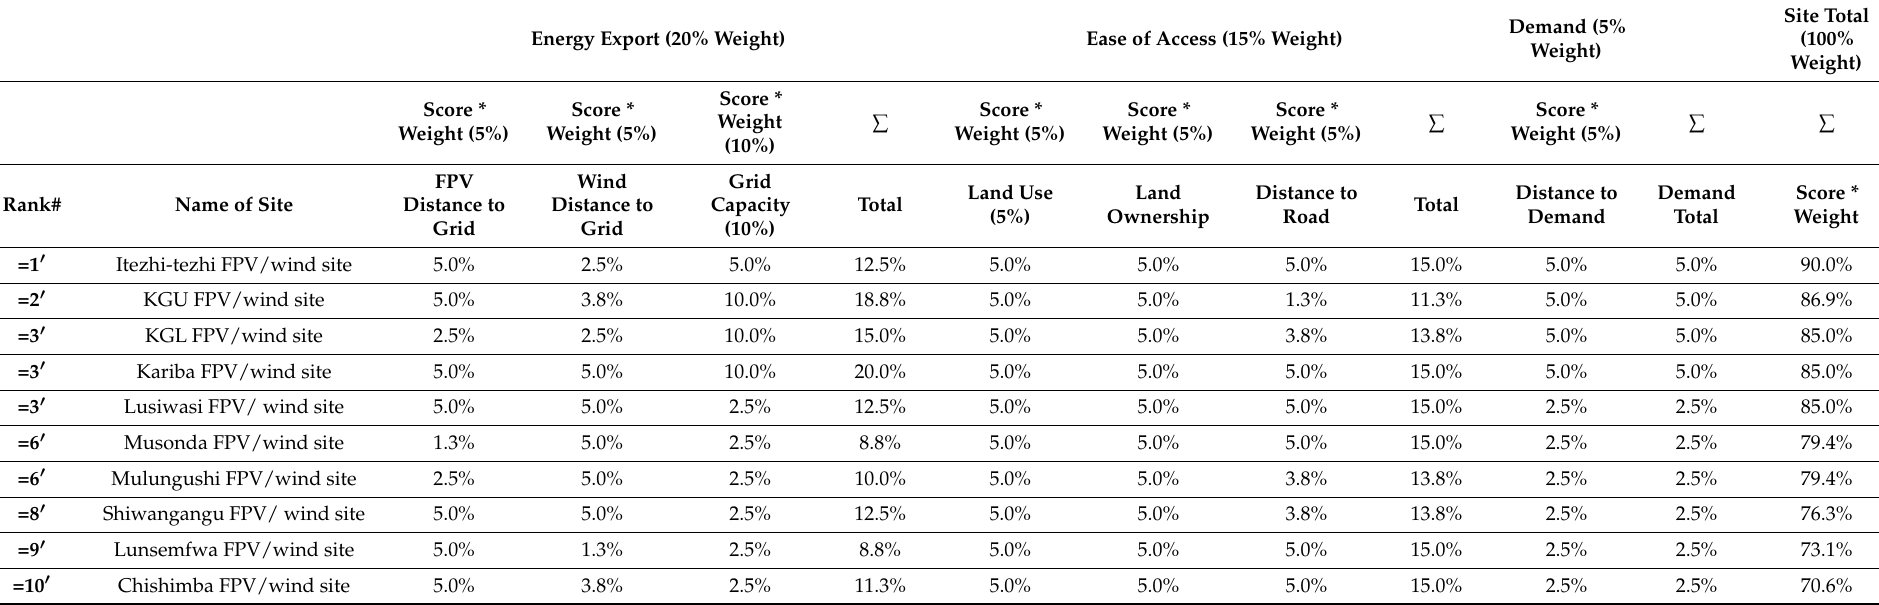
Table A3. Showing continuation of balanced scoring and ranking matrix